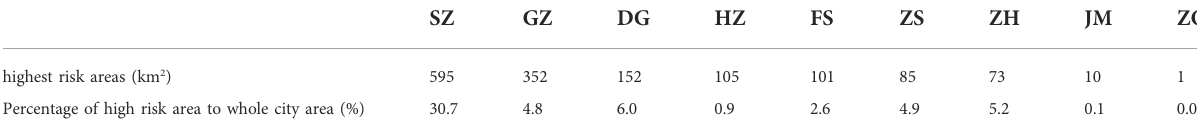
TABLE 4 Area and percentage of highest risk zones in each city under the original scenario.